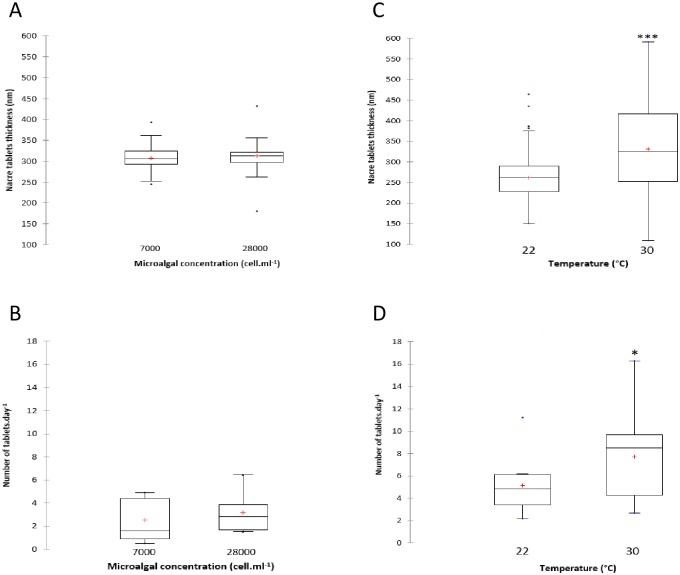
Pearl nacre tablet thickness and number of tablets deposited per day in pearl oyster Pinctada margaritifera after one month at different (A and B) microalgal concentrations and (C and D) water temperatures.Each plot includes: mean (“+” cross in the box-plot), median (solid bar in the box-plot), 25th to 75th percentiles represented in the rectangular box, 1.5×interquartile range (non-outlier range of the box whiskers), minimum and maximum values (extreme dots) and outlier values (outside box whiskers). Statistical analysis is based on the Mann-Whitney test for pearl nacre tablet thickness and on the Student’s t-test for number of tablets deposited per day. Statistical significance is indicated by asterisks as follows: *p < 0.05, ***p < 0.001. (A and C: n = 270 per condition; B and D: n = 9 per condition).